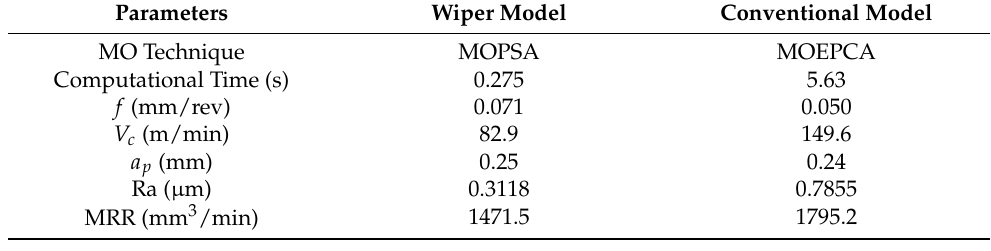
Table 8. Comparison between the best optimal results of both models, wiper and conventional. Parameters